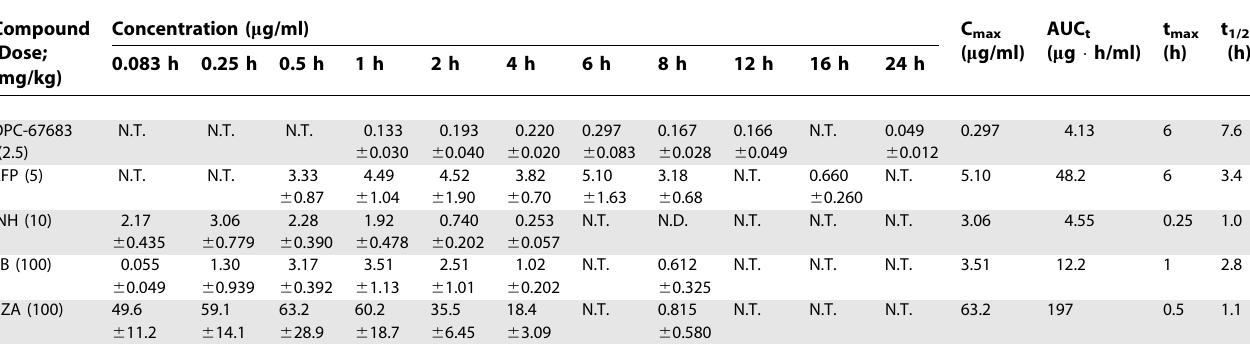
Table 7. Plasma Concentration of OPC-67683, RFP, INH, EB, and PZA after Oral Administration in Mice Infected with M. tuberculosis Kurono Compound Concentration ( l (Dose; mg/kg)